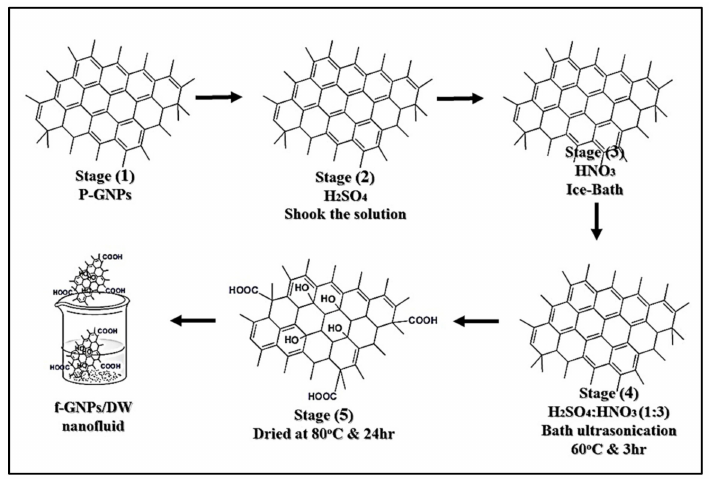
Figure 2. Schematic of the functionalization process and fabrication of nanofluids.